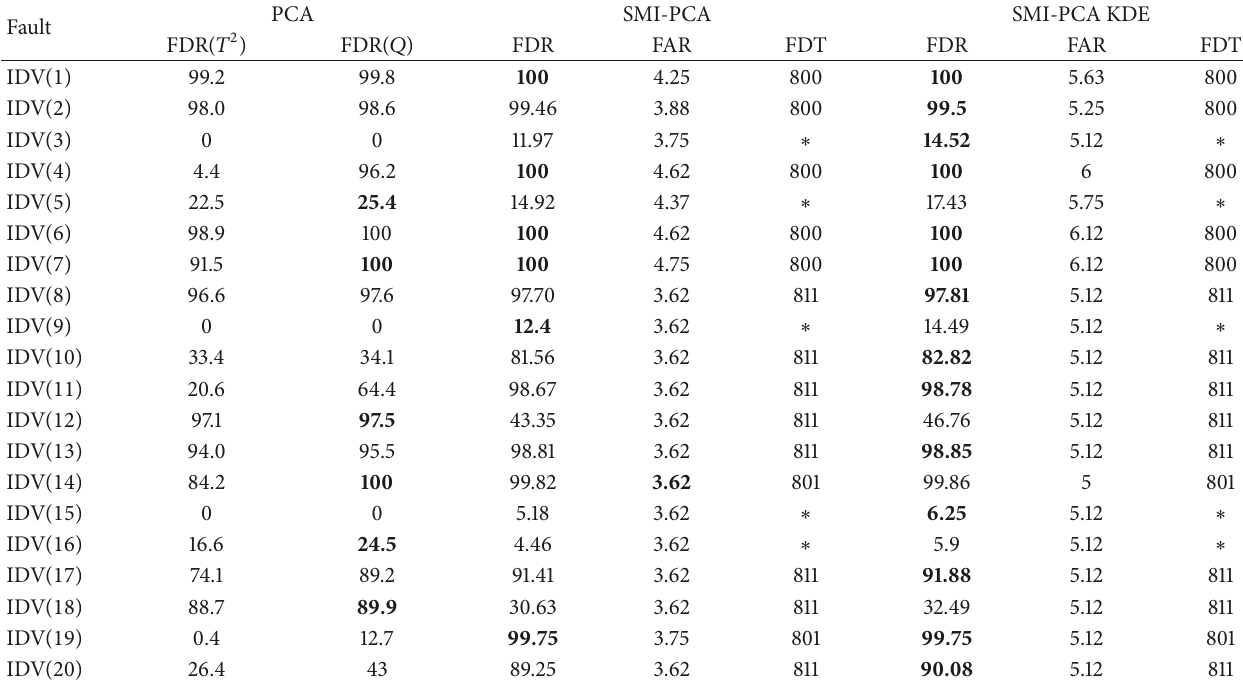
Table 4: TE process: fault detection for test data